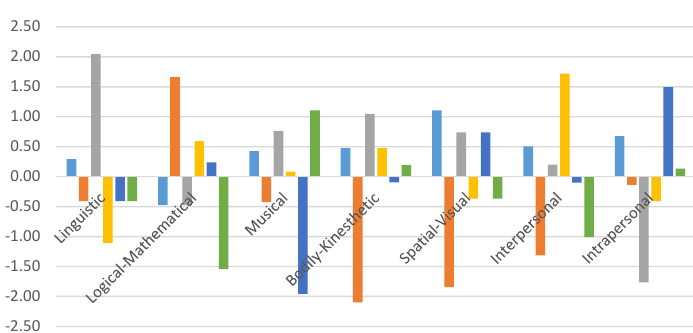
Figure 1. Individuals standard z -scores for the adopted seven